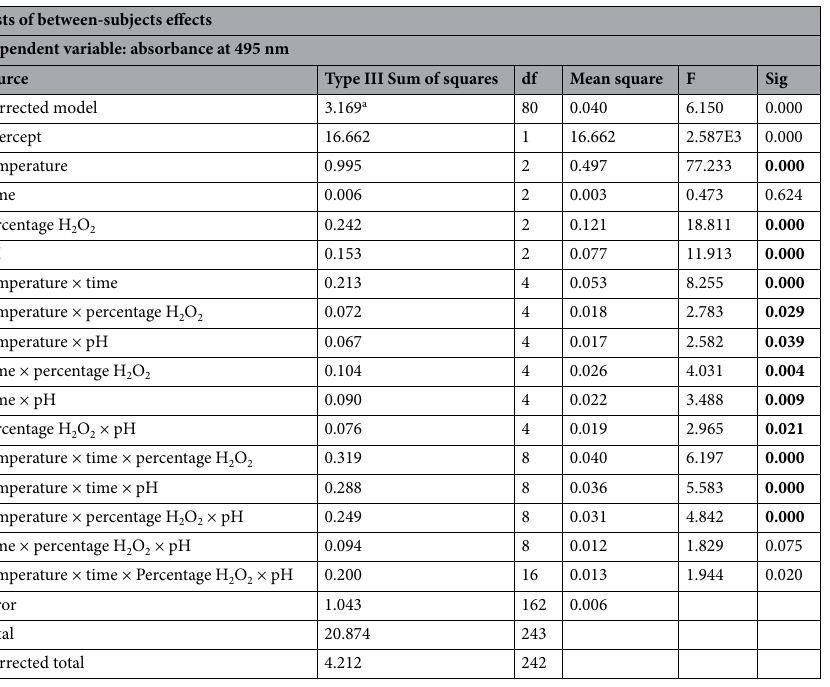
Table 2. Effect of temperature, time duration, pH and hydrogen peroxide % on the decolorization of biosurfactant (ANOVA table for univariate analysis, p < 0.05). a R Squared = 0.752 (Adjusted R Squared =